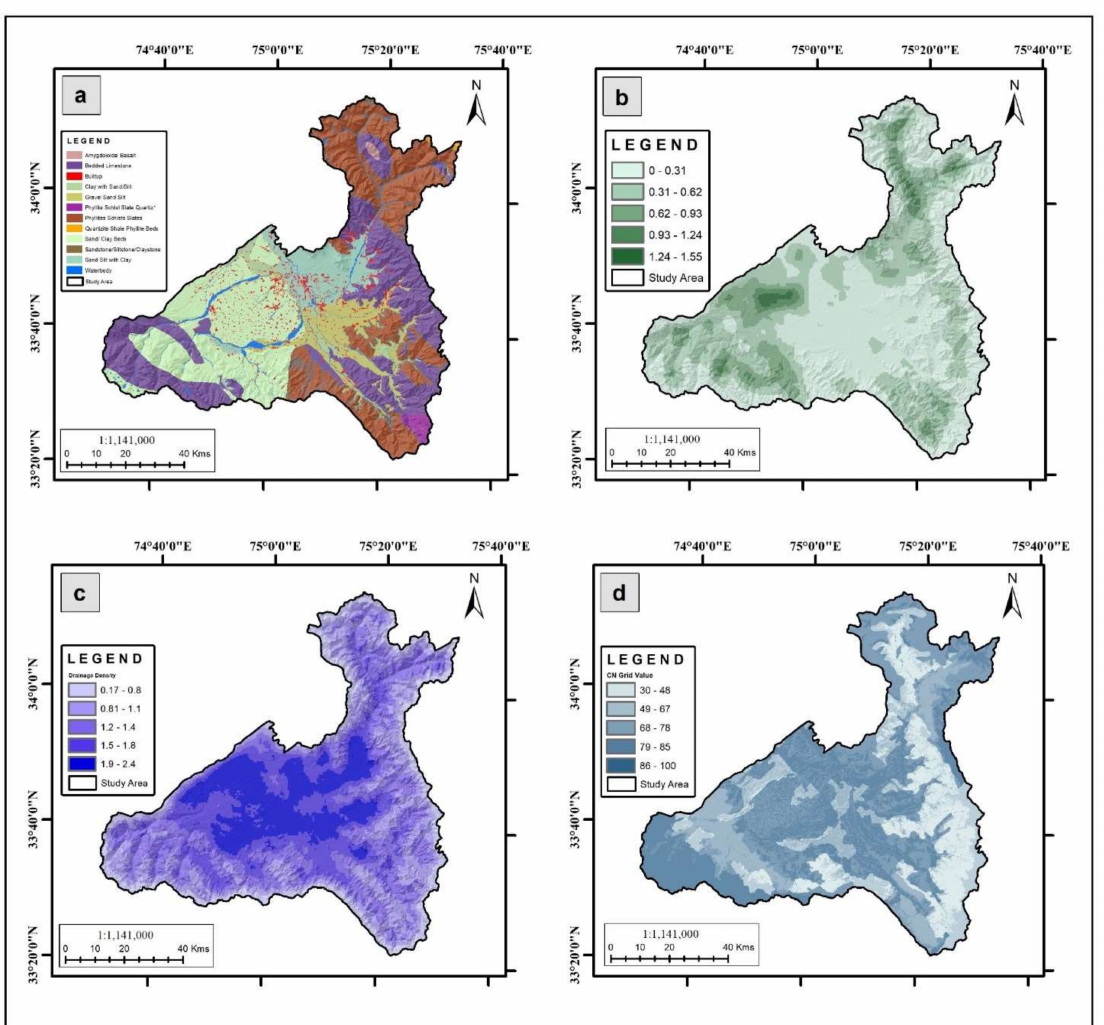
Figure 4. ( a ) Lithology ( b ) Lineament ( c ) Drainage density ( d ) CN Grid of the study